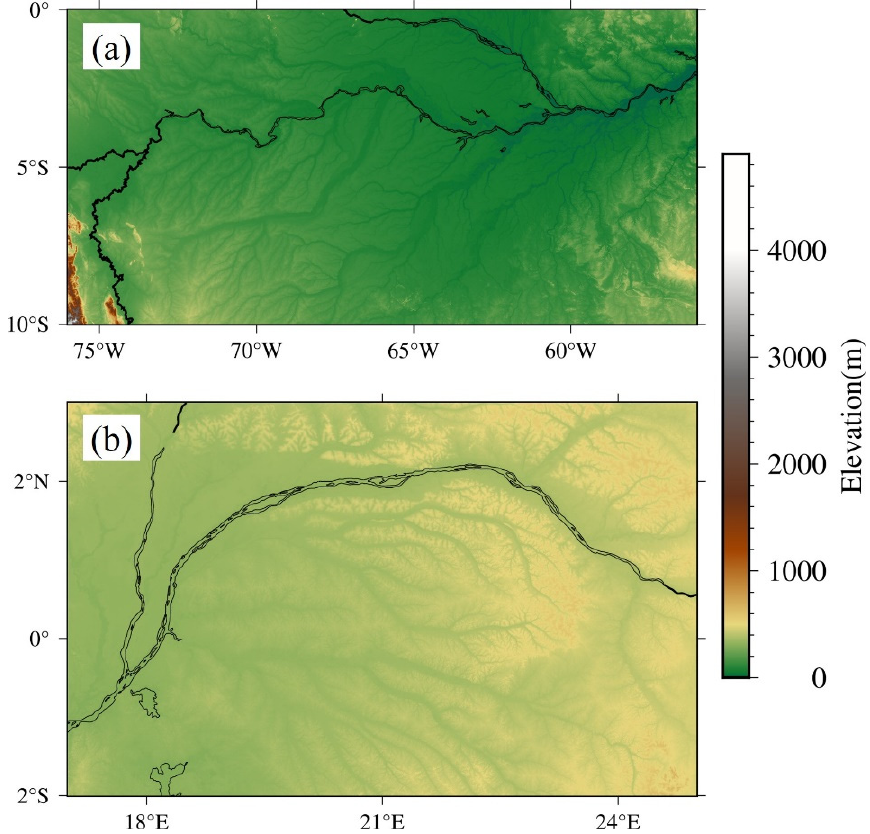
Figure 1. Relief maps of the Amazon Basin ( a ) and the Congo Basin ( b ) with major rivers marked. The Congo Basin is located in west-central Africa, covering an area of nearly 3.7 million km 2 . It stretches from the coast of the Gulf of Guinea to the mountains of the Albertine Rift and is crossed by the equator and the Inter-Tropical Convergence Zone (ITCZ) [33]. The Congo Basin contributes to half of Africa’s freshwater discharge into the Atlantic Ocean [34]. It includes the largest and most diverse forest massif on the African continent and the second largest extent of tropical rainforest in the world, next to the Amazon Basin [35]. About 40% of the Congo Basin is covered by the savannas, which are a significant part of the